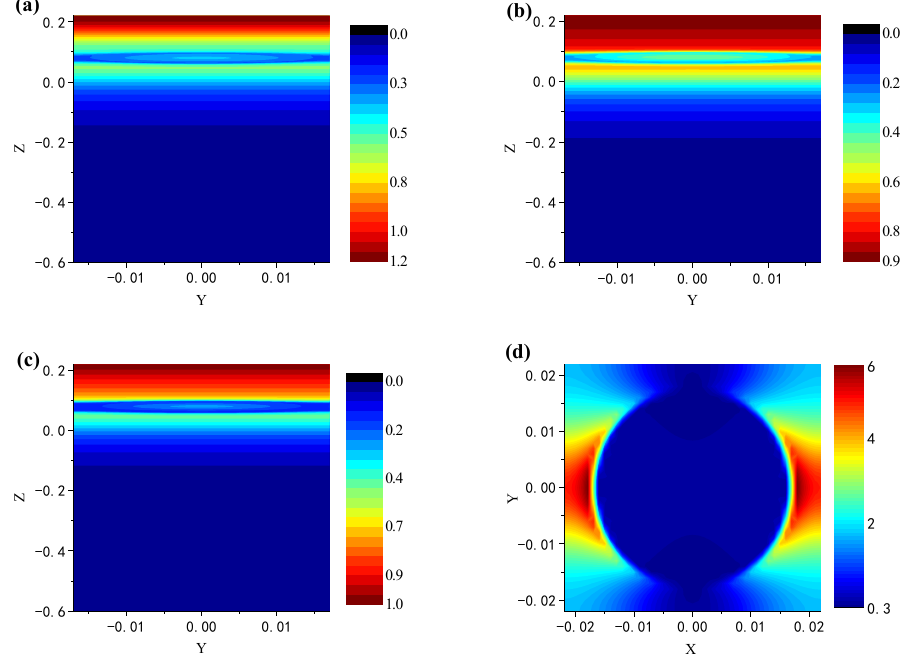
Figure 10. Electric field distribution of MXene/tungsten-based absorber: The electric field distribution at wavelength ( a ) 627 nm, ( b ) 1189 nm, and ( c ) 1735 nm on the X = 0 plane; ( d ) electric field distributed on the Z = −60 nm plane when the wavelength is 627 nm.